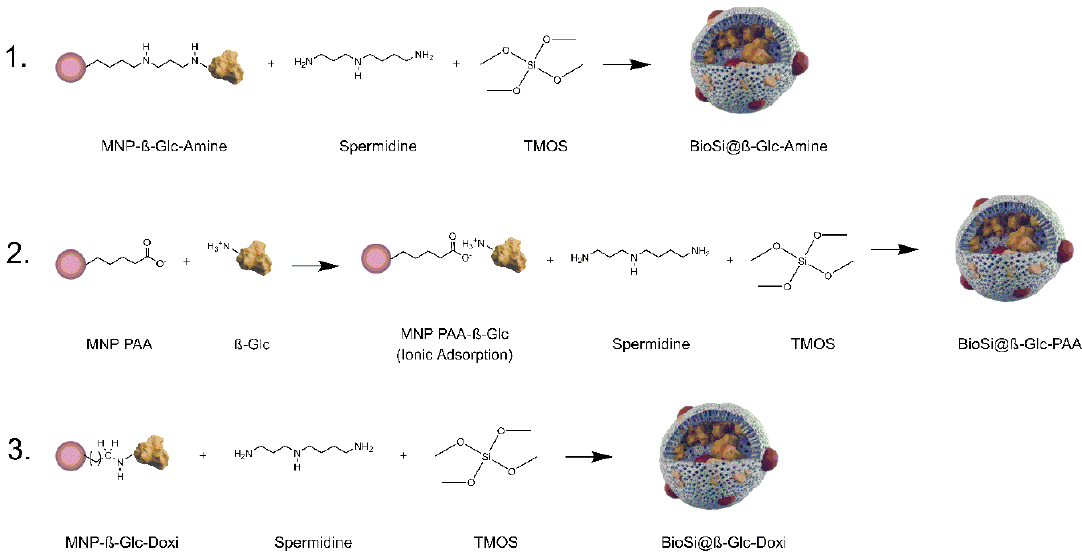
Figure 2. Thermal stability of b-Glc preparations at 75 ◦ C. Soluble b-Glc (circles), b-Glc immobilized onto aminated (100 nm) MNPs (MNP Amine—triangles), b-Glc immobilized onto oxidized carboxylated MNPs (MNP DOxi—squares).